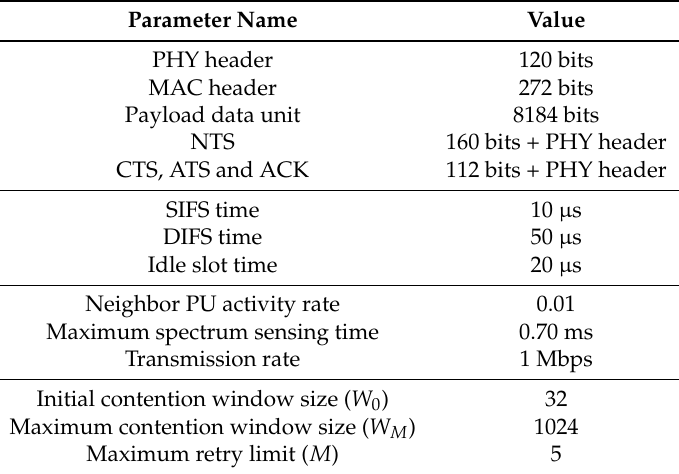
Table 2. Default simulation parameters.